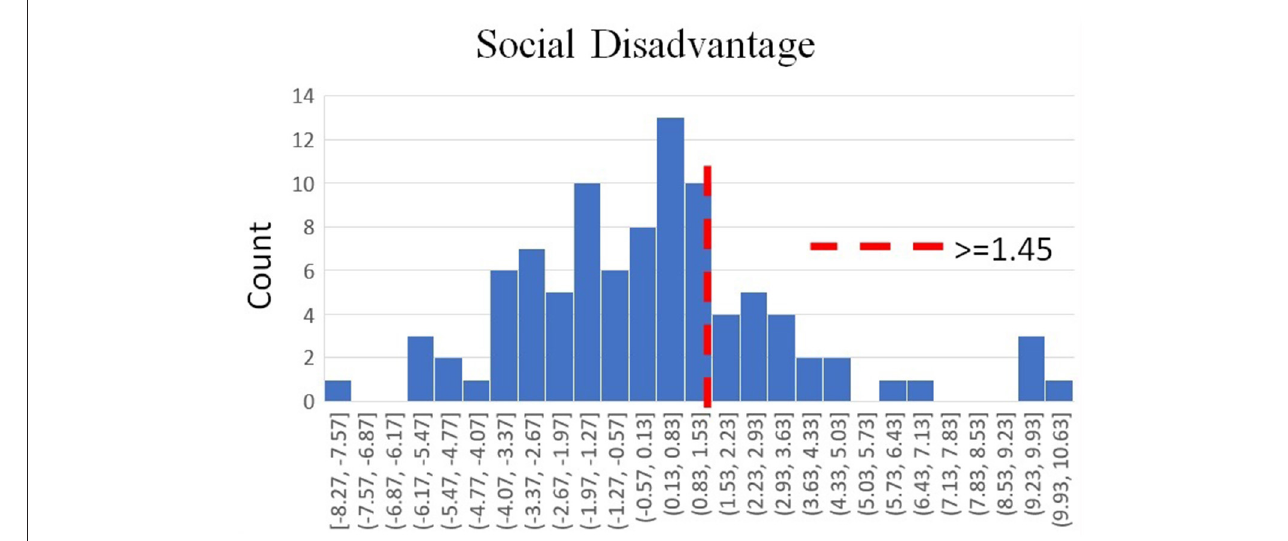
FIGURE 2 | Histogram of the composite